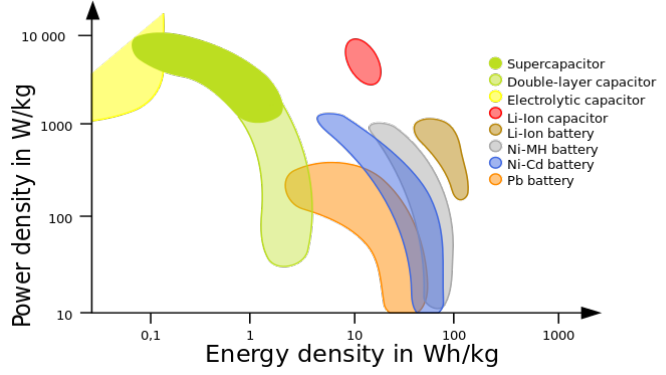
Figure 3. Power vs. energy density